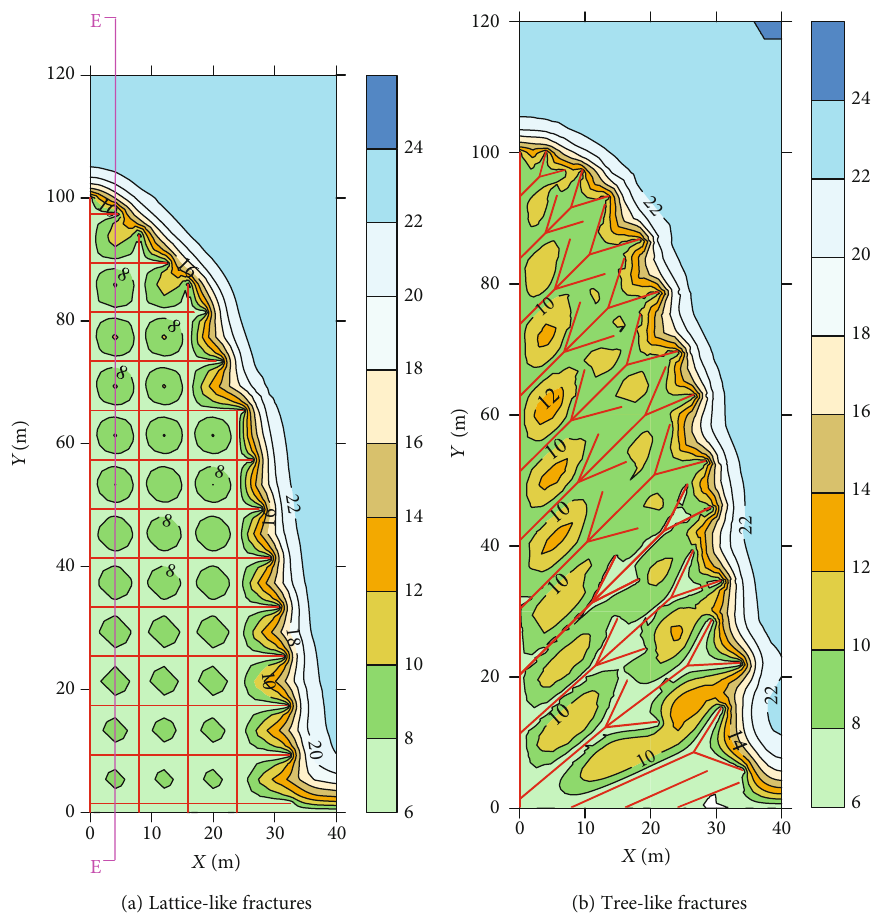
Figure 4: Pressure distribution contour maps after 10 days (unit: MPa).